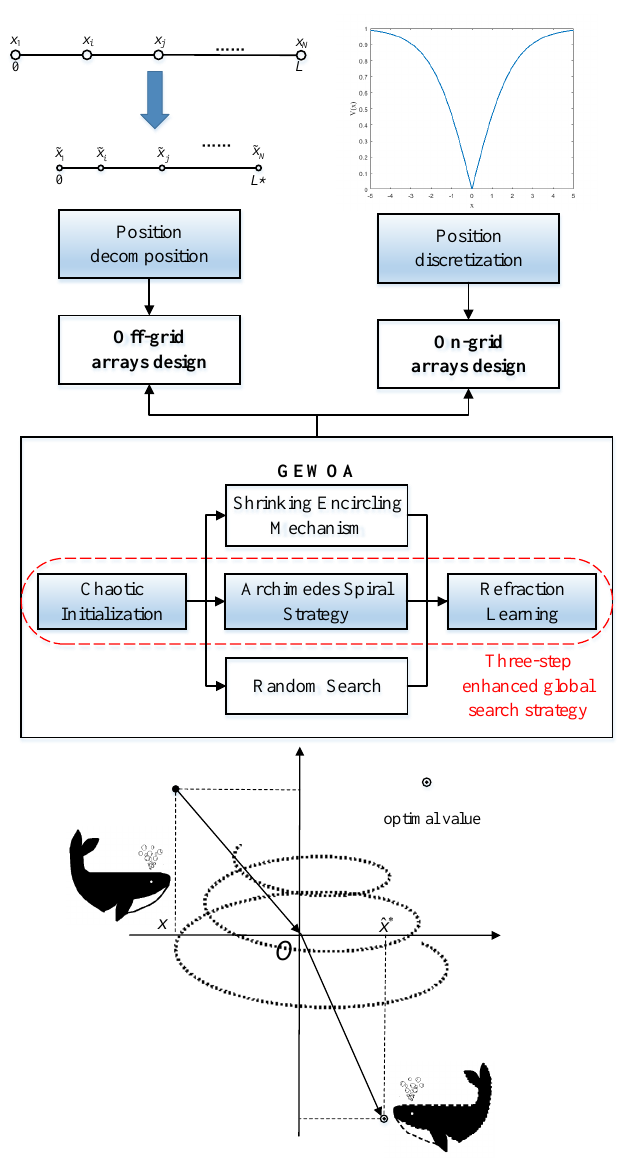
Figure 2. Flowchart of the GEWOA